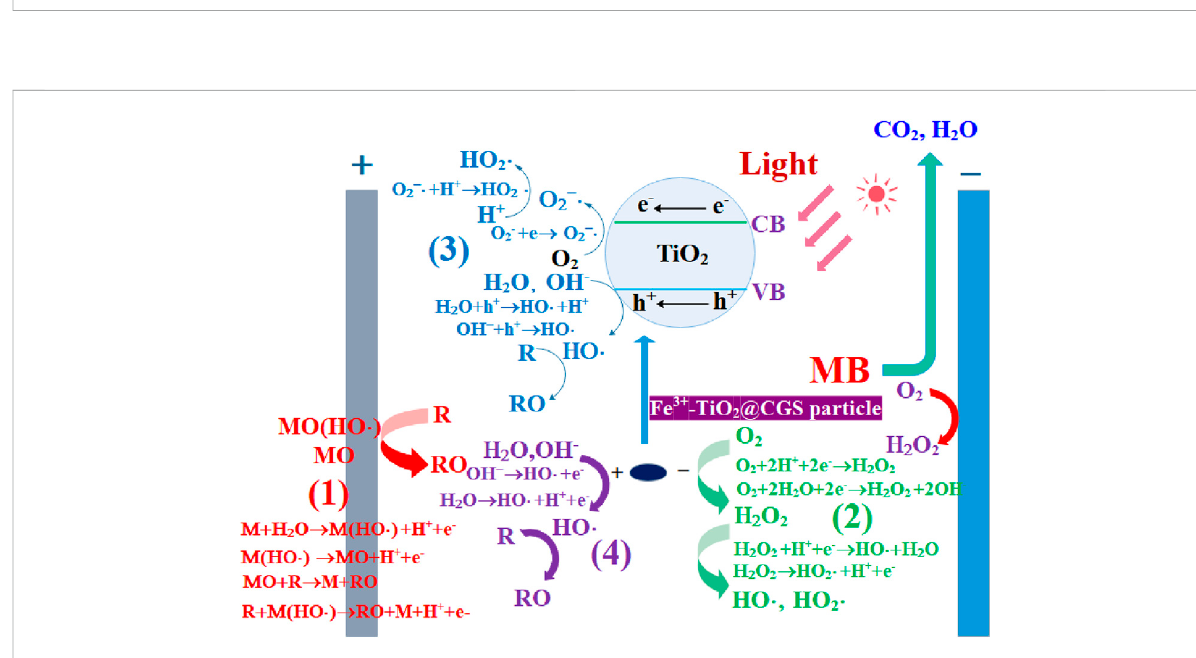
FIGURE 7 Mechanism diagram of MB degradation by three-dimensional electrode photoelectric